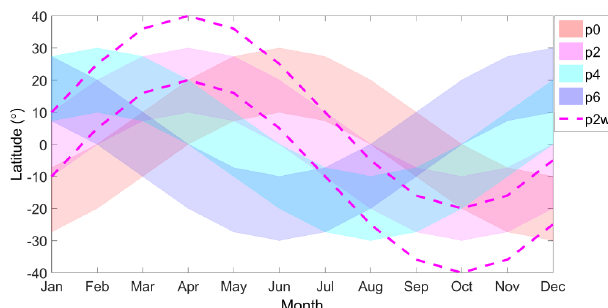
Figure 2. Seasonally changing injection areas in p0, p2, p4, p6 and p2w